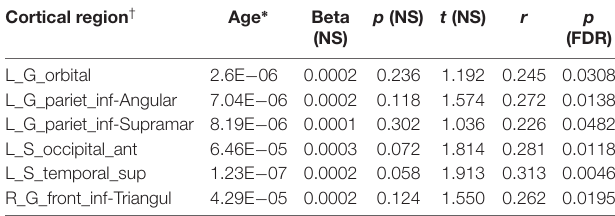
TABLE 5 | Androsterone association with cortical thickness.